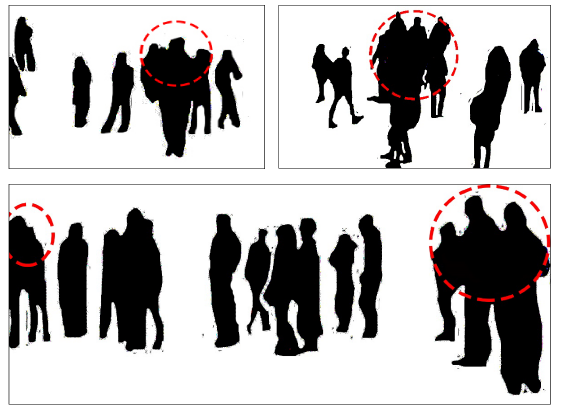
Figure 13. The detailed results of some challenging images of obstruction